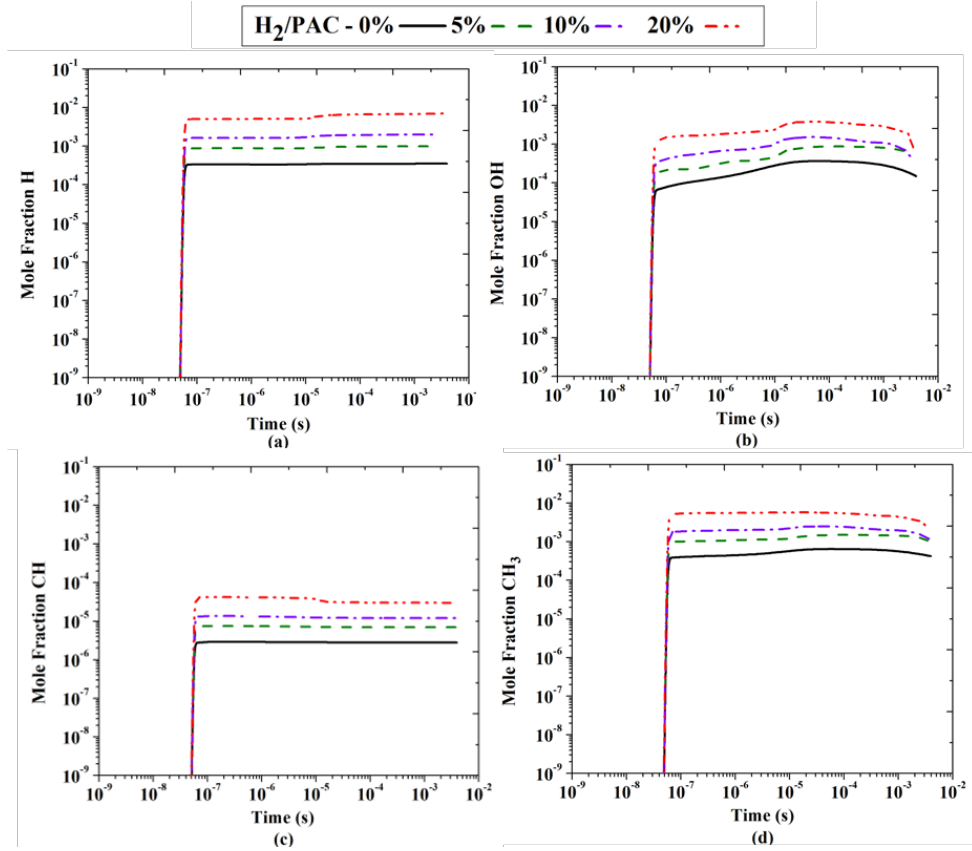
Figure 4. Temporal evolution of ( a ) H, ( b ) OH, ( c ) CH, ( d ) CH 3 concentrations at different contents